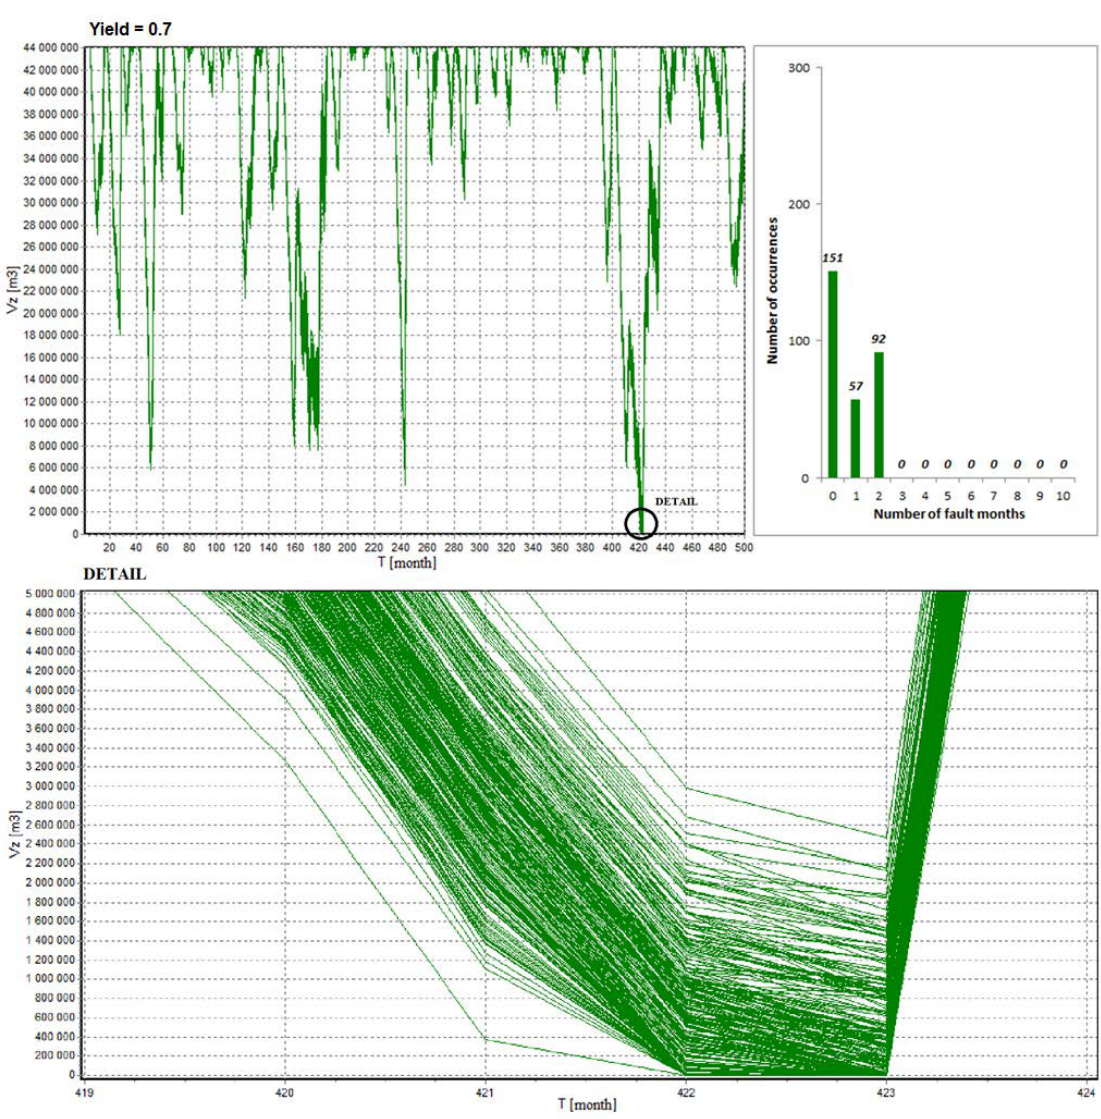
Figure 4. Ensemble of reservoir filling considering water losses from the reservoir for the initial uncertainties of ± 9% for 300 random numbers and for reservoir yield 0.70, the histogram of failure months and detail with zero, one or two failure months. The vertical axis is the reservoir storage volume Vz (m 3 ) and the horizontal axis is the time step T (month).